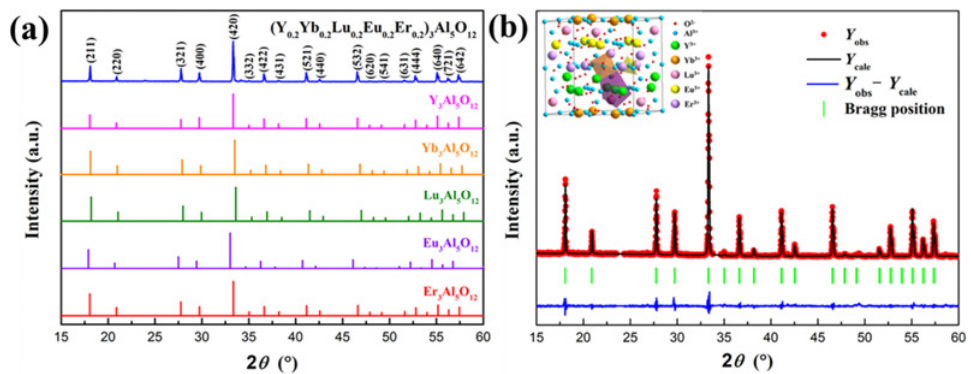
Fig. 2 (a) XRD patterns of the as-synthesized HE-RE 3 Al 5 O 12 powders together with those of Y 3 Al 5 O 12 (33-0040), Yb 3 Al 5 O 12 (70-4980),